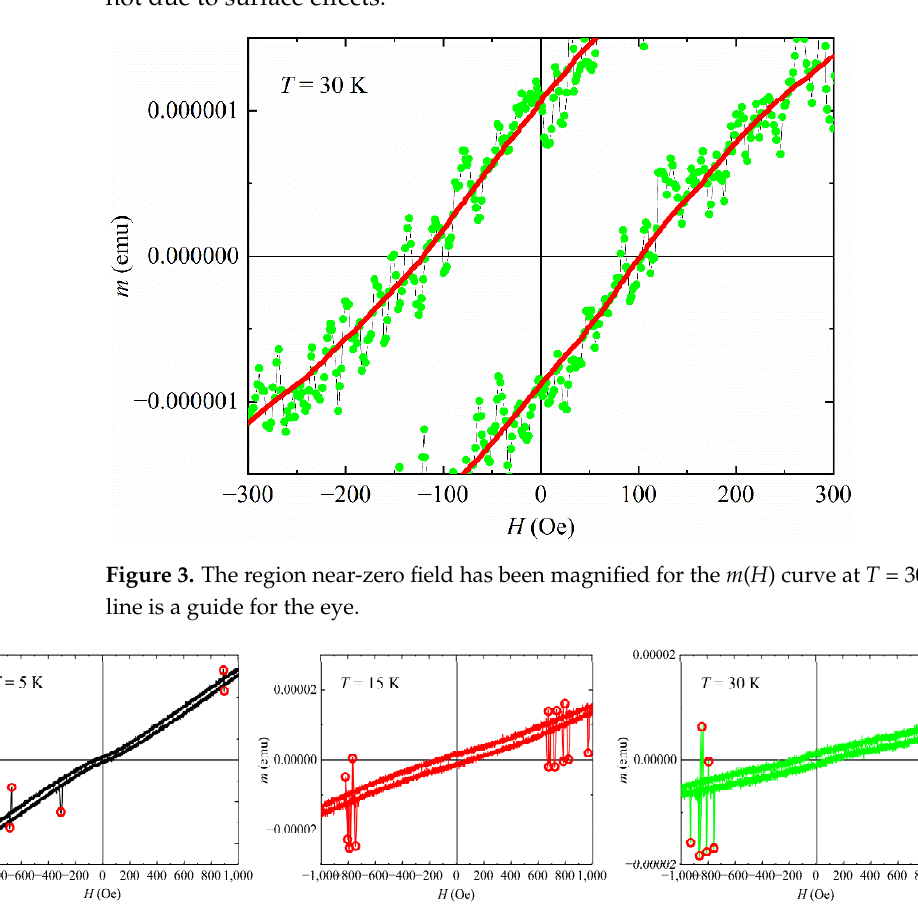
Figure 3. The region near-zero field has been magnified for the m ( H ) curve at T = 30 K. The red solid line is a guide for the eye.